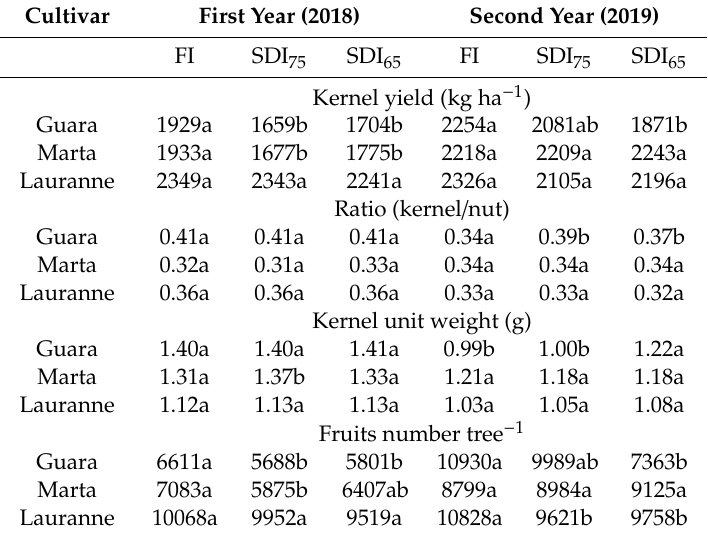
Table 2. Impact of irrigation strategies on yield components during the studied years.